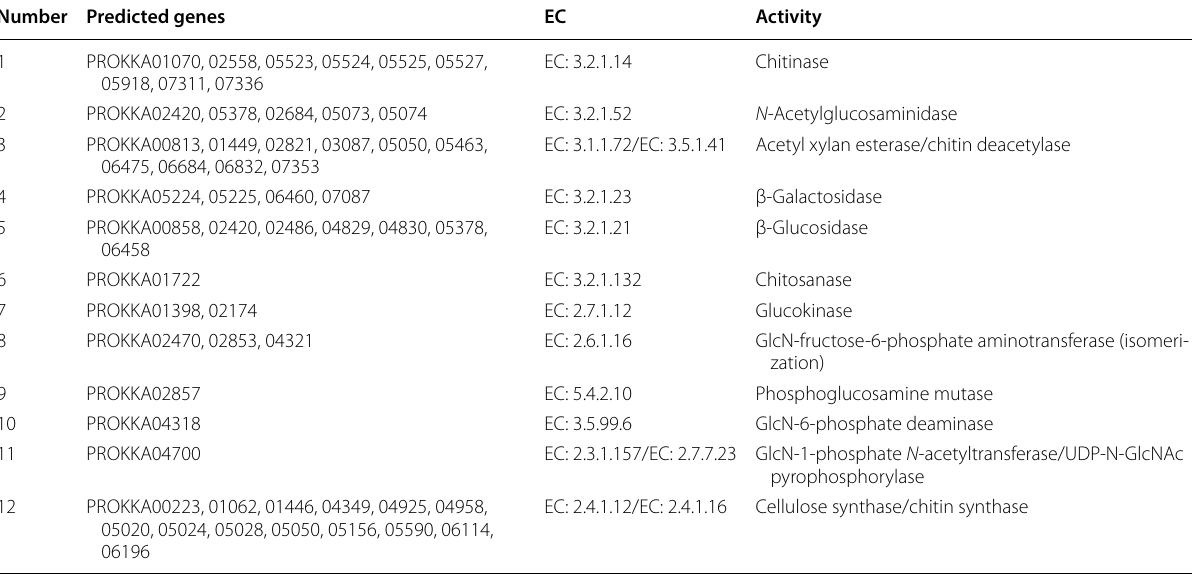
Table 4 Genes encoding enzymes involved in chitin metabolism Number Predicted genes EC